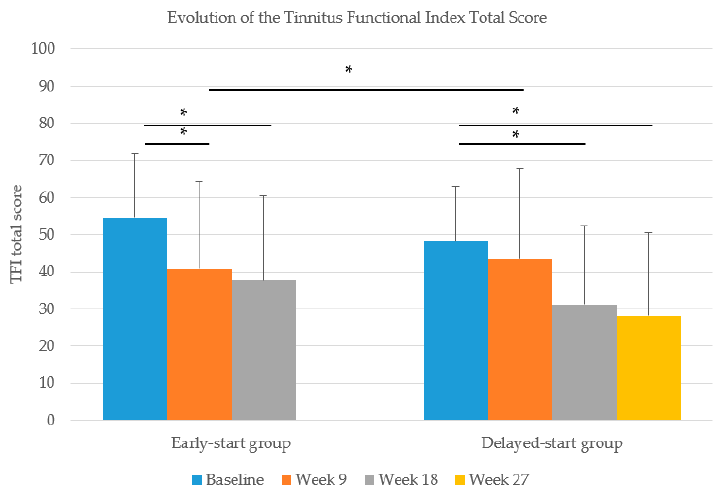
Figure 3. Evolution of the Tinnitus Functional Index (TFI) scores in the early start and delayed start groups (error bars show the standard deviations, * p < 0.05).